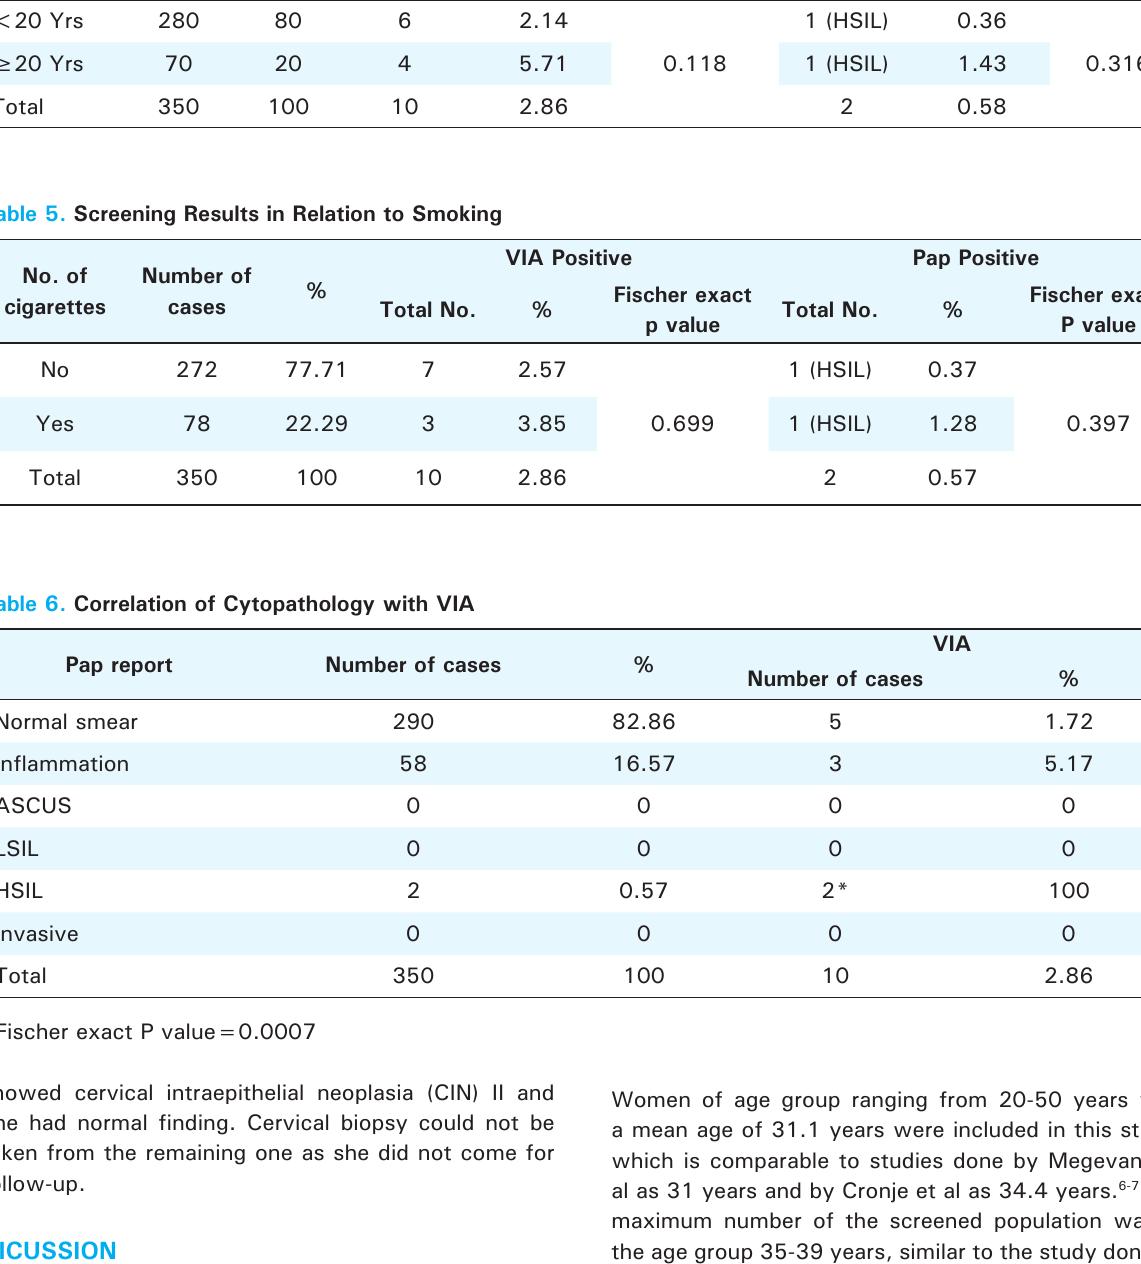
table 4. screening results in relation to Age at Marriage VIA Positive Pap Positive Age at number % Fischer exact marriage of cases total no. % total no. % X 2 P value p value